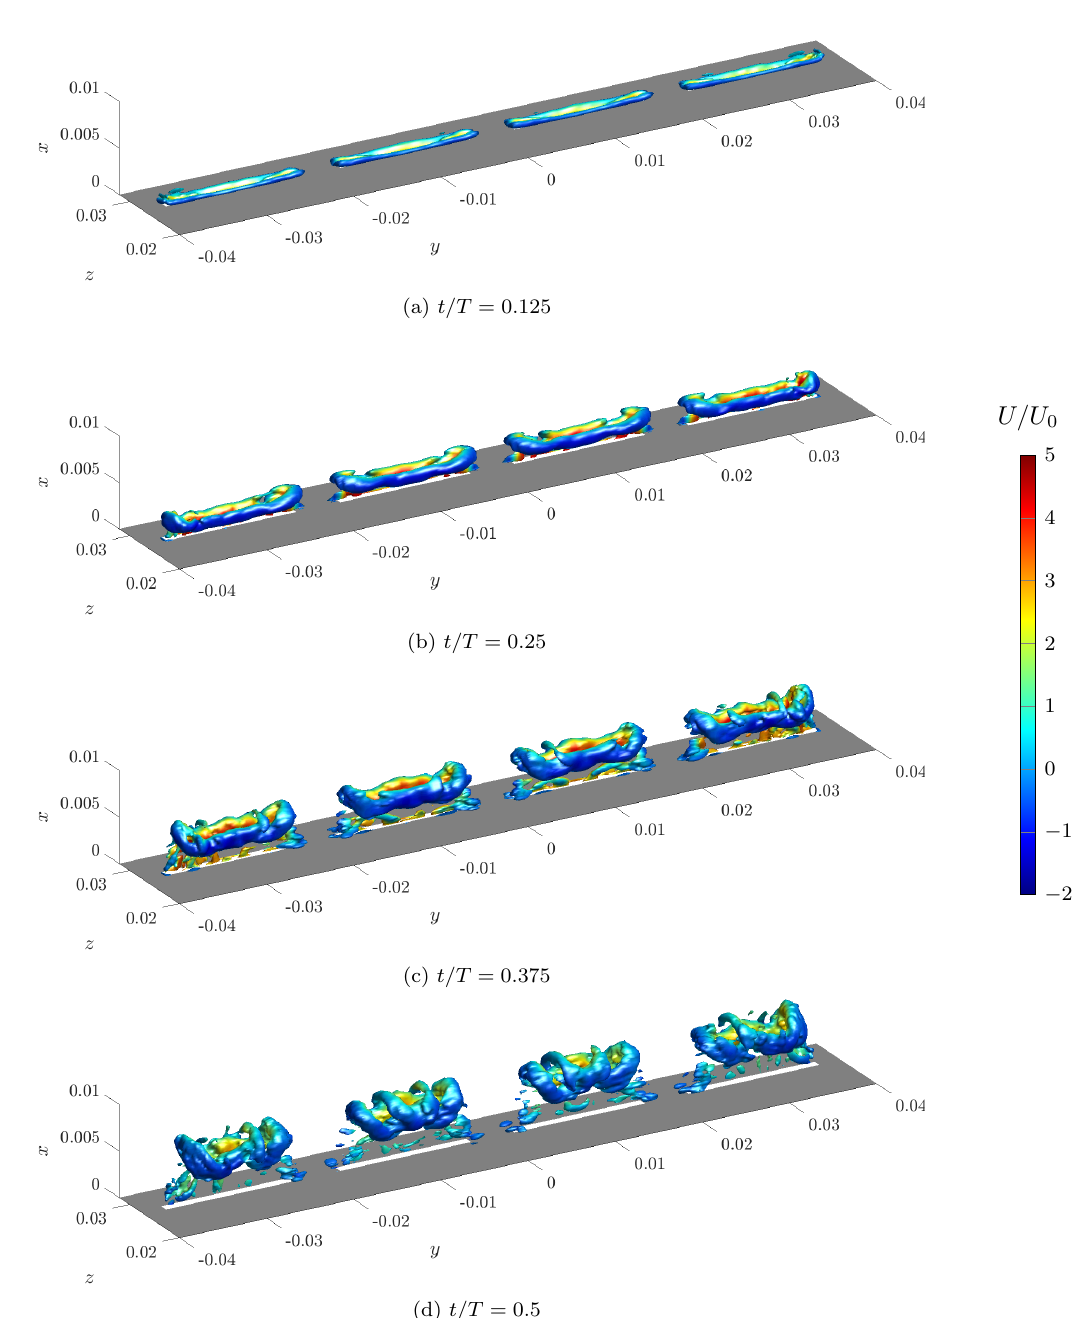
Figure 8. Evolution of the vortical structures in the near-field for the central slots, visualized by Q = 0.02 isosurfaces. Ejection phase. The isosurfaces are colored with the phase-averaged streamwise velocity component U / U 0